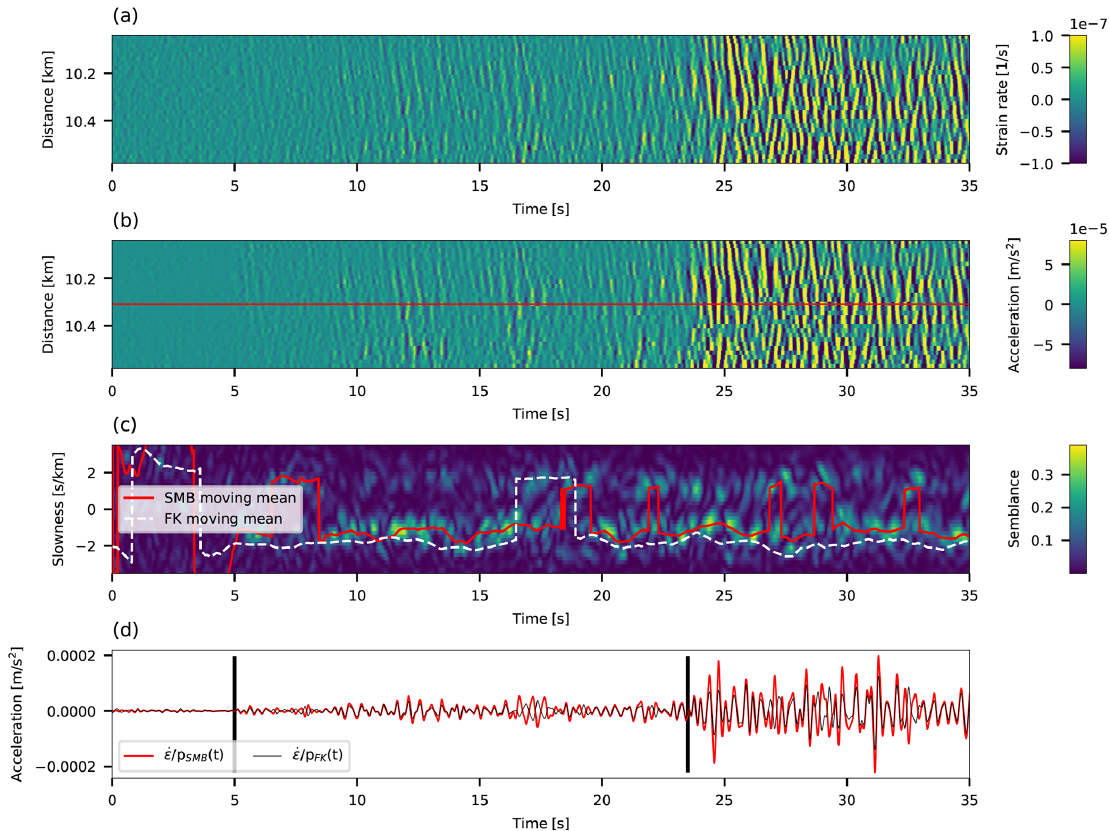
Figure 8. Slant-stack conversion for traces between 10.05 and 10.6km along the NESTOR cable of an M L 3 . 6 earthquake recorded at a hypocentral distance of 140km. Both P- ( ∼ 5s) and S-wave ( ∼ 23 . 5s) arrivals are shown. (a) Strain-rate time series for 29 adjacent traces. (b) Strain rate converted to accelerations for all 29 traces. (c) Slowness as a function of time color coded by semblance values for the middle channel, indicated by the red line in (b) . Red and dashed white curves correspond to semblance- and FK-derived smoothed slowness. (d) Acceleration converted using semblance- and FK-derived slowness are indicated by red and black curves,